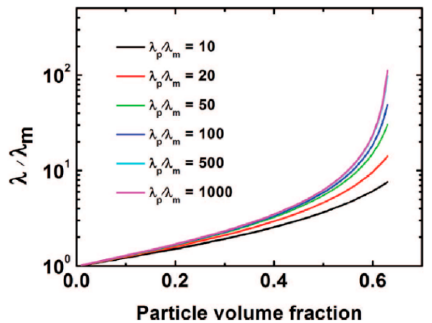
Figure 37. Theoretical prediction of the relative thermal conductivity ( λ ) of composites (© 2016 IEEE. Reprinted, with permission, from [59]).